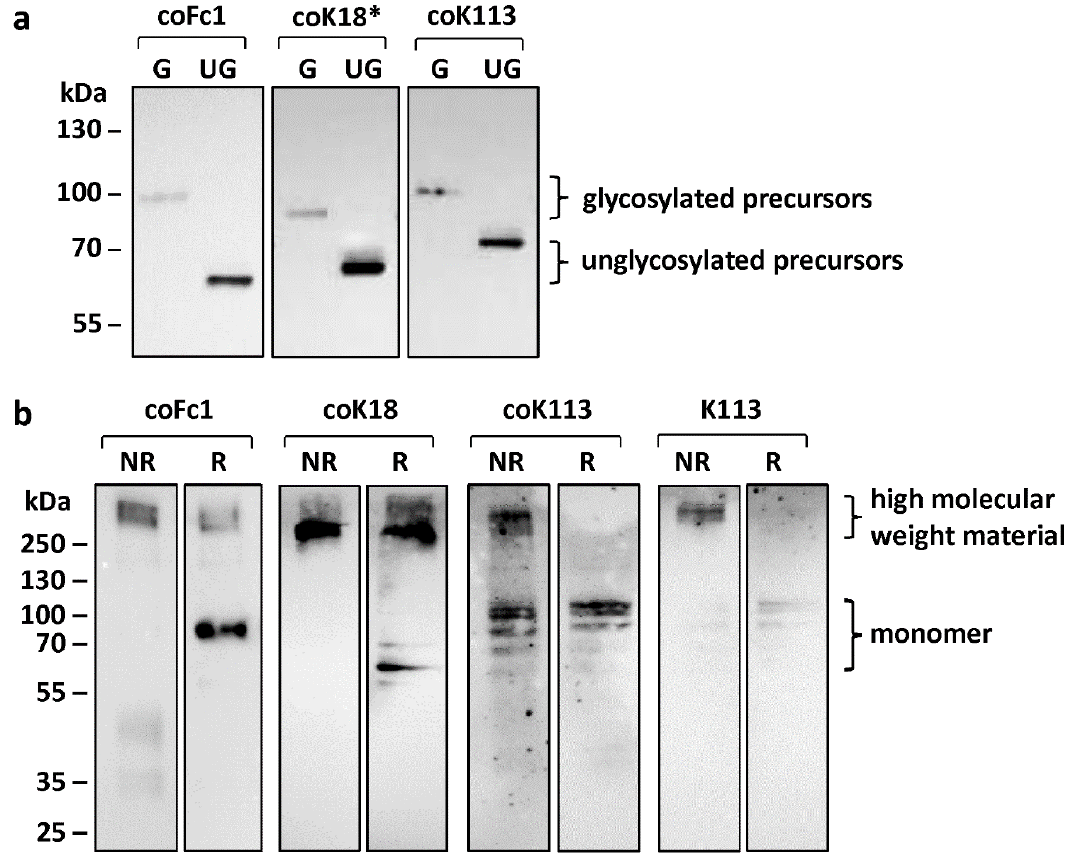
Figure 2. Western blot analysis for characterization of post-translational modifications of HERV ENV.